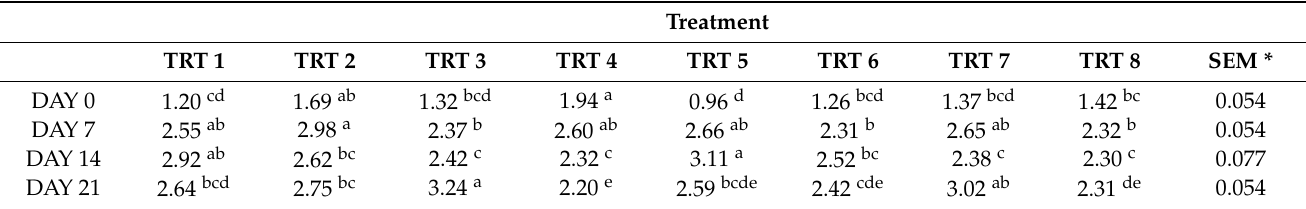
Table 7. Interactive influence of treatment × day of display on microbial spoilage organisms (APC) of ground beef during a simulated retail